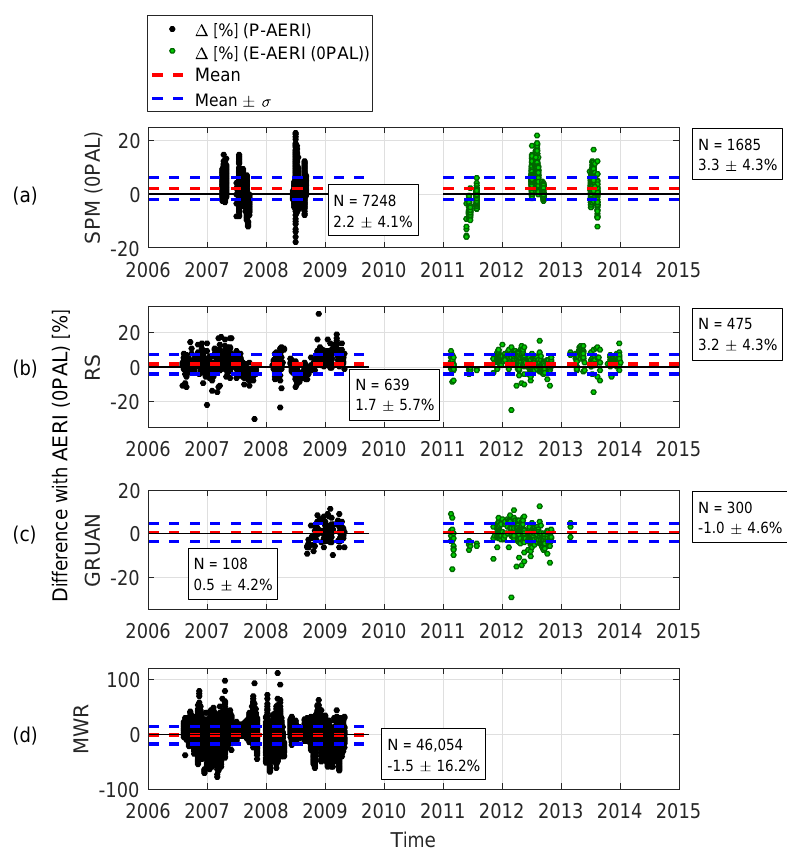
Figure 9. Same as Fig. 8 but for 0PAL-based AERI percent difference comparisons with 0PAL and EWS instruments. (Percent differences calculated using Eq. (2) where X is P-AERI or 0PAL